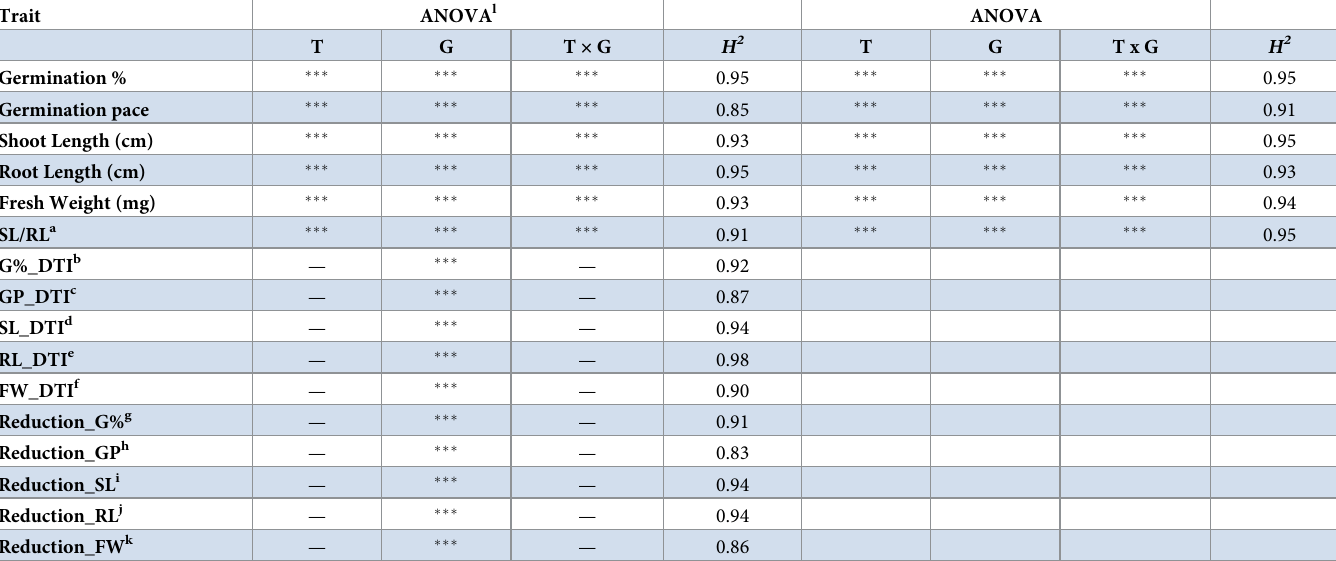
Table 2. Heritability and analysis of variance for 193 barley genotypes under control and drought stress conditions for all traits.